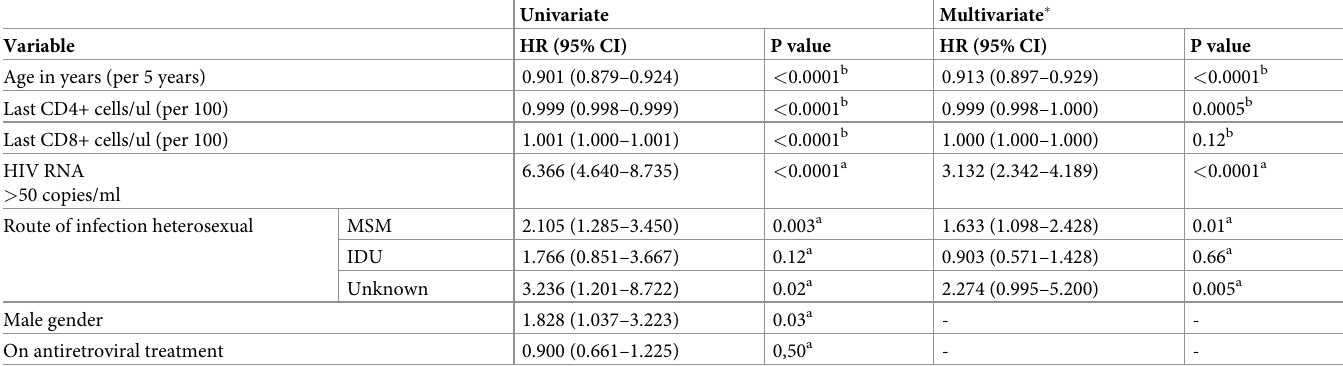
Table 3. Univariate and multivariate survival analyses for positive upper respiratory tract swab